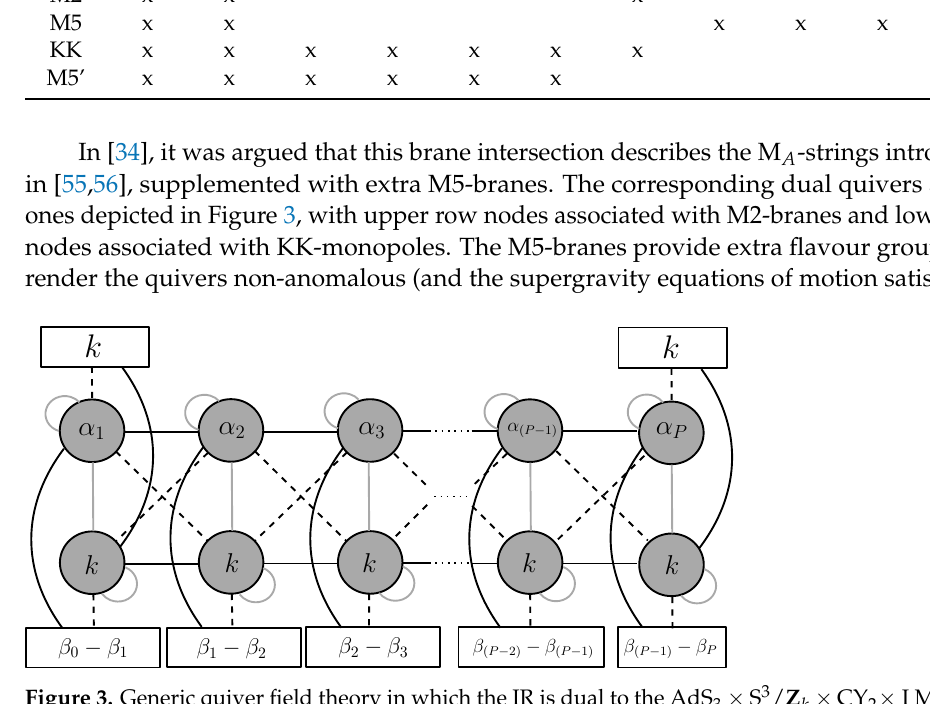
Figure 3. Generic quiver field theory in which the IR is dual to the AdS 3 × S 3 / Z k × CY 2 × I M-theory solutions defined by the functions in (6) and